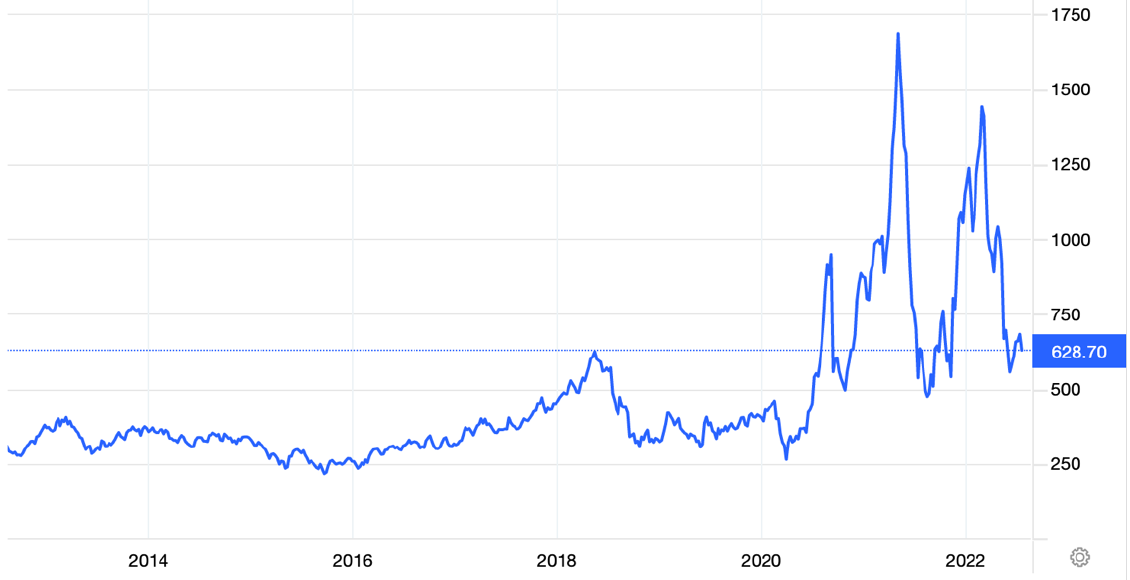
Figure 11. Lumber prices in USD in the last decade.